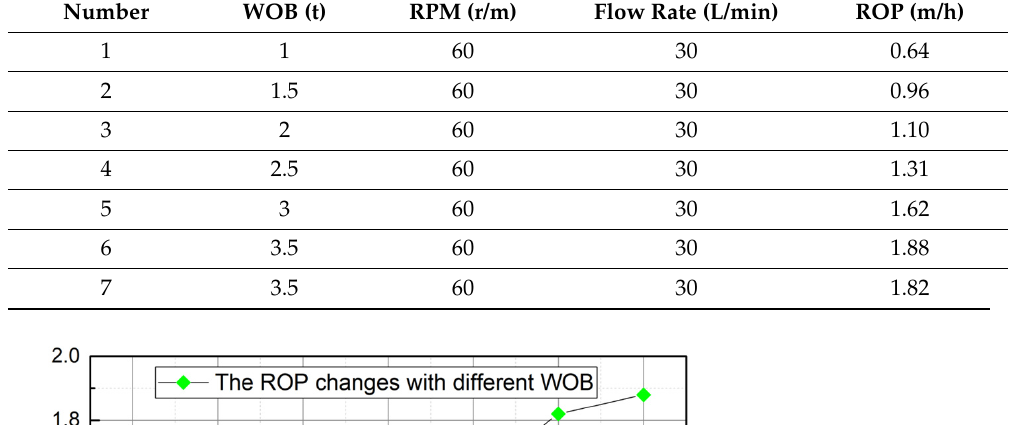
Figure 11. Drilling test of bionic core bit in hard rock. ( a ) Recovery core in the test; ( b ) Drill bit before the test; ( c ) Drill bit after the test; ( d ) Side view of the drill bit after testing; ( e ) Drill bit during lifting down.